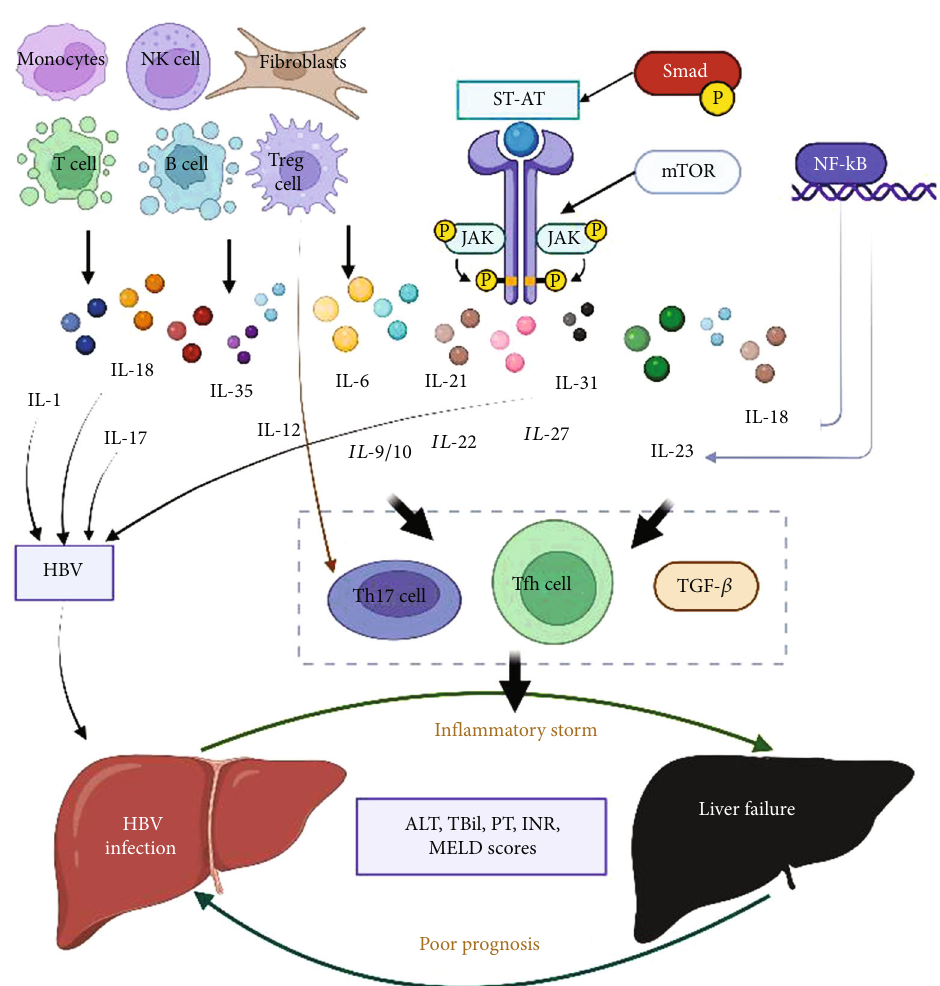
Figure 1: E ff ects of ILs on the prognosis of HBV-ACLF and its mechanism. (Illustration: the picture shows the main cells producing ILs; the key mechanisms of di ff erent ILs a ff ecting the prognosis of ACLF; the key signaling pathways that can regulate the function of ILs, and the key cytokines that cause the in fl ammatory storm of liver and summarized the whole paper brie fl